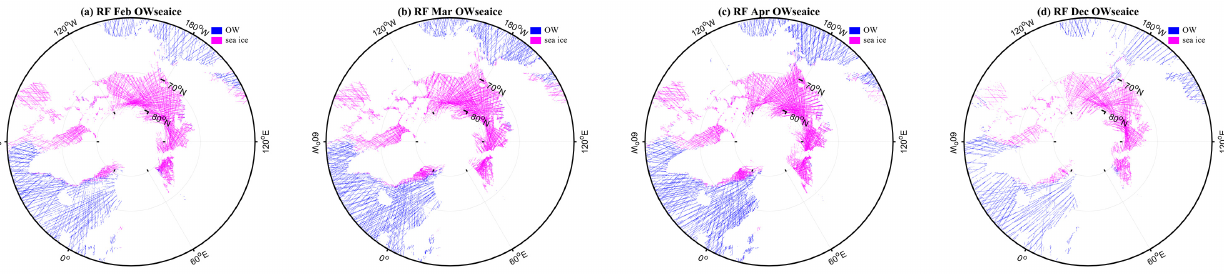
Remote Sens. 2021 , 13 , x FOR PEER REVIEW 22 of 28